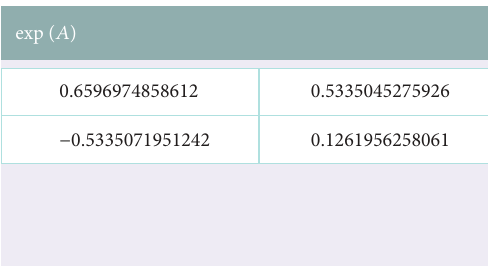
Figure 9: Matrix exp (𝐴)